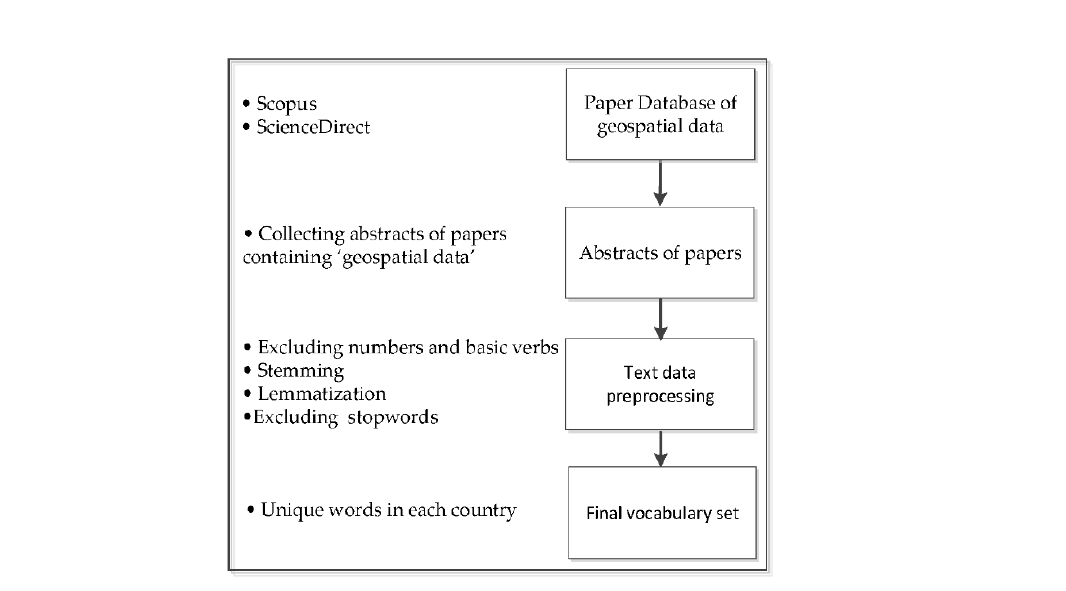
Figure 1. Process of data collection and pre-processing.